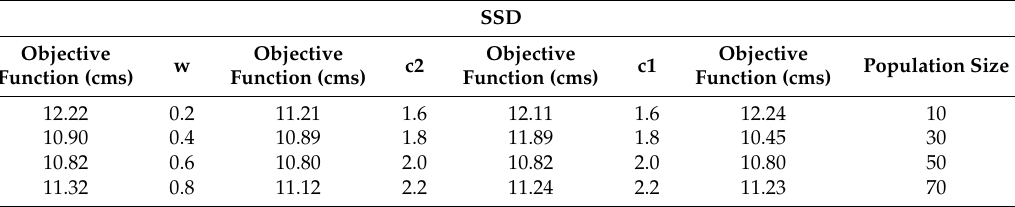
Table 3. Analysis for the performance of the Particle Swarm Optimization (PSO) (Wilson